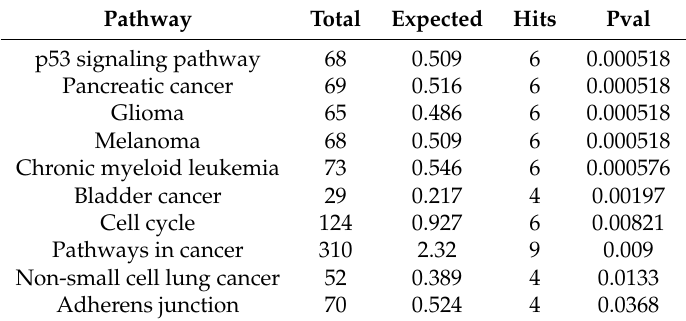
Table 10. Top 10 miRNet enrichment analysis results for miRNAs hsa-miR-378*,